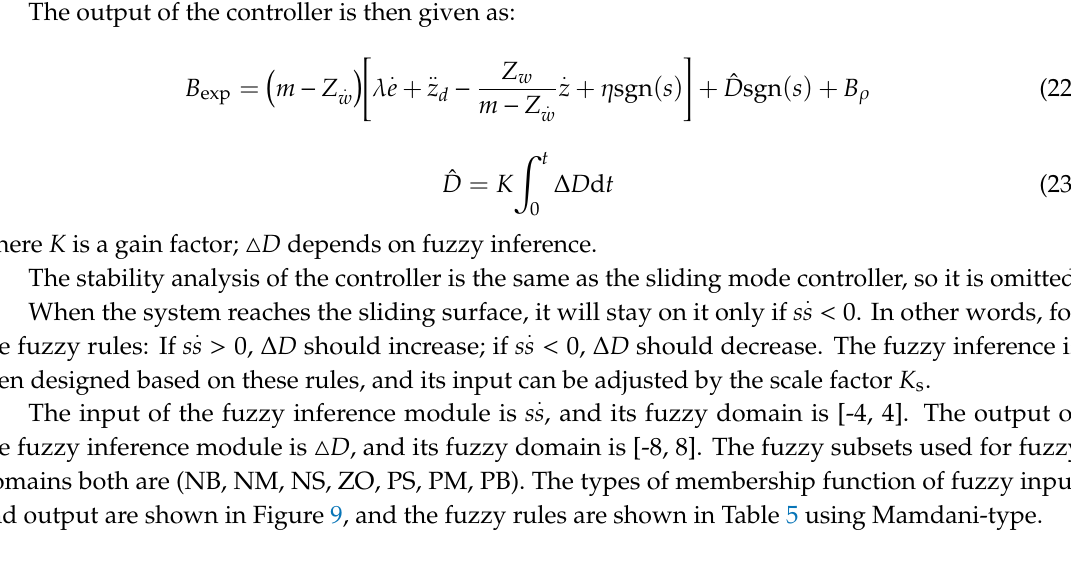
Figure 9. Types of membership function of input and output variables. Table 5. Fuzzy control rules for input variable ss .